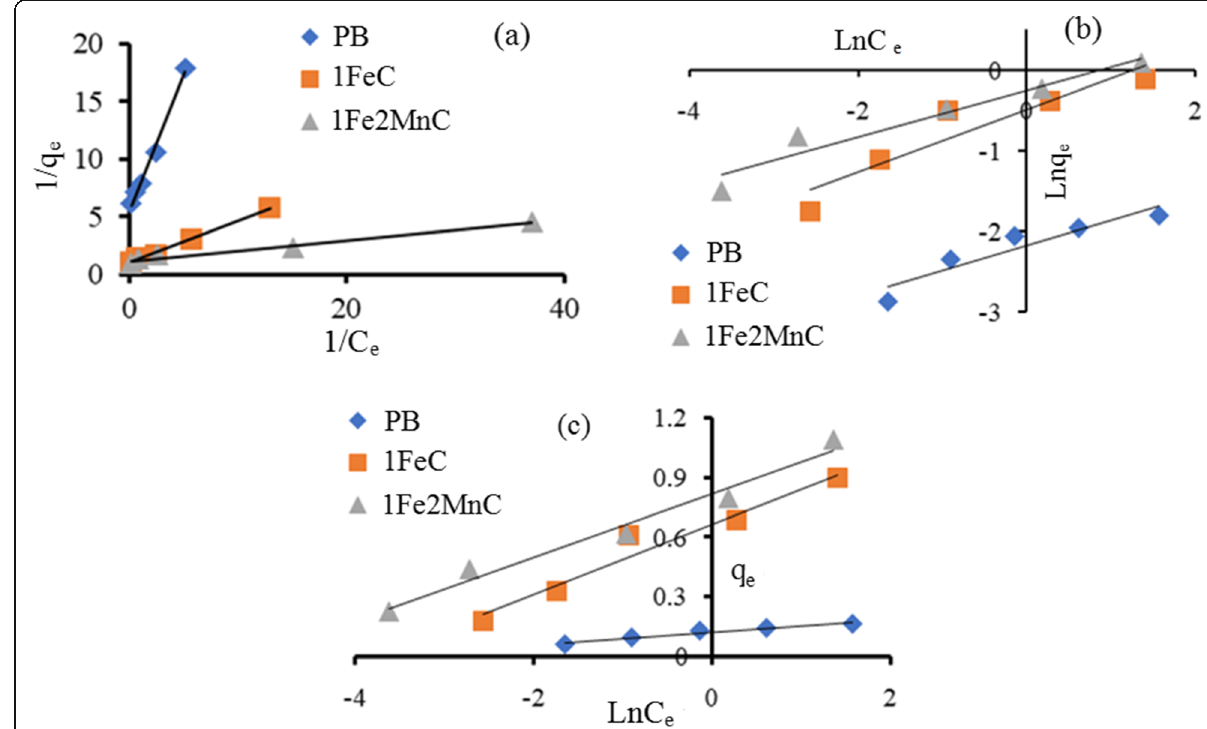
Fig. 11 Adsorption isotherm analysis of a Langmuir; b Freundlich and c Temkin